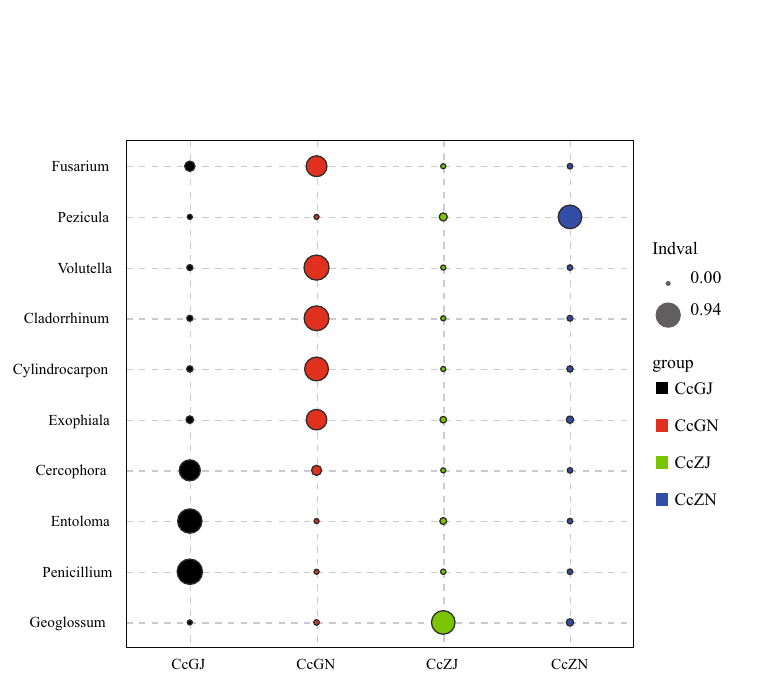
Figure 4. Analysis of indicator species of fungi in the rhizosphere and endosphere of healthy and diseased Cc . Node size represents the average relative abundance of one genus in each sample